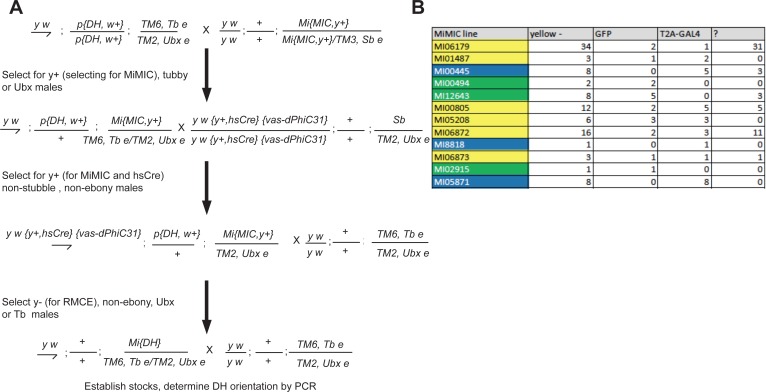
Crossing scheme for Double Header and data of integration.(A) Crossing scheme for mobilizing Double Header RMCE cassette and selecting RMCE events. (B) PCR determination of the Double Header orientation. ? indicates the number of lines where PCR pattern was ambiguous. Yellow MiMICs: Double Header insertions in both orientations, Green MiMICs: only GFP protein trap orientation, Blue MiMICs: only T2A-GAL4 gene trap orientation.